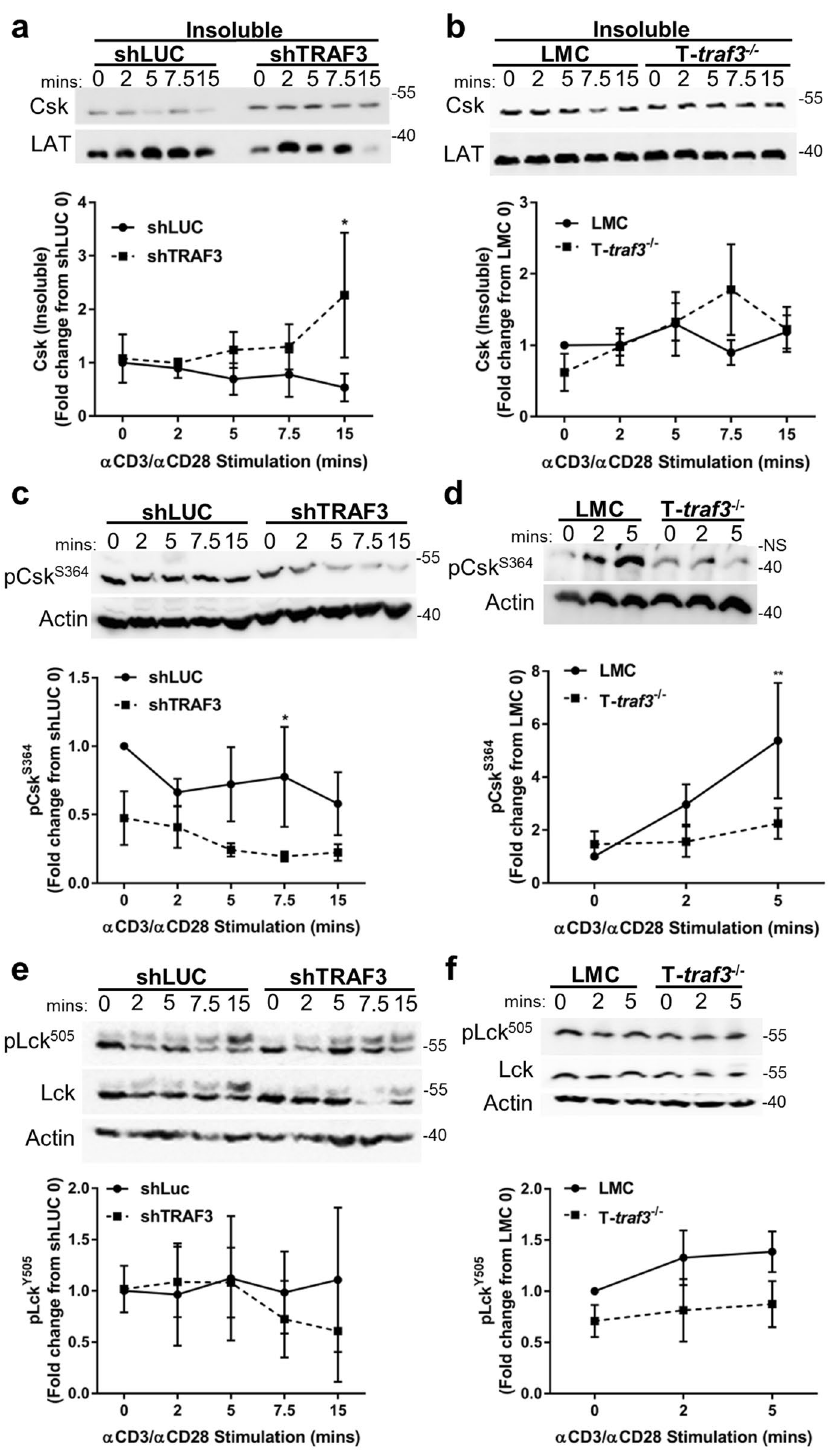
Figure 3. Role of TRAF3 in the regulation and localization of Csk. T cells were stimulated with α CD3/ α CD28 Abs for the indicated times and a cellular fractionation was performed, as described in Methods, on lysates from shLUC and shTRAF3 cells ( a ) or isolated primary mouse splenic T cells from LMC and T- traf3 − / − mice ( b ). Western blot analysis of the insoluble (membrane) fractions was performed to detect the designated proteins, with actin or LAT serving as loading controls (Top panel). Expression levels of Csk were first normalized to actin and the subsequent fold change was calculated from the control 0 time point (bottom panel). Data from T- traf3 − / − cells stimulated for 7.5 minutes is trending towards significance with p = 0.0597. Western blot analysis was performed on whole cell lysates from human T cell lines ( c ) or primary mouse splenic T cells ( d ) and blotted for pCsk S364 (Top panel). Expression levels of pCsk S364 were first normalized to actin and subsequent fold change was calculated from the control 0 time point (bottom panel). Western blot analysis was